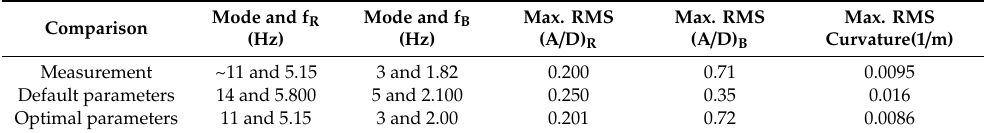
Figure 13. Comparison between the measured and predicted response frequencies for the 2/2 configuration for flow speed between 0.5–1.2 m/s. Table 12 presents the measured responses from the experiment by Rao et al. [16] and the predicted responses from an optimal dataset of excitation coefficient parameters. The results show that the mode has been correctly predicted and the error in the frequency prediction is within 10%